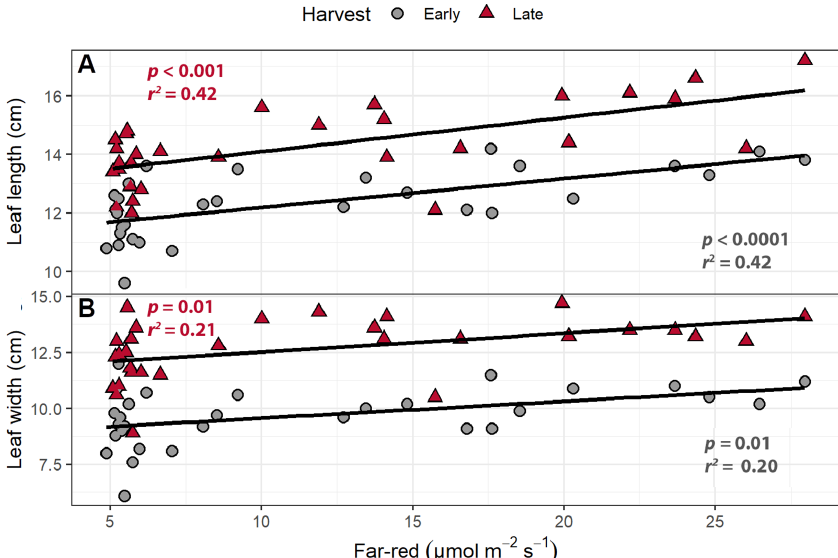
Figure 1. ( A ) The relationship between supplemental far-red light intensity and leaf length and ( B ) leaf width of “Green Salad Bowl” lettuce. Plants were grown under a photosynthetic photon flux density of 207 ± 13 µmol m − 2 s − 1 supplemented with varying amounts of far-red. The early harvest occurred 16 days after germination, while the late harvest occurred 25 days after germination.